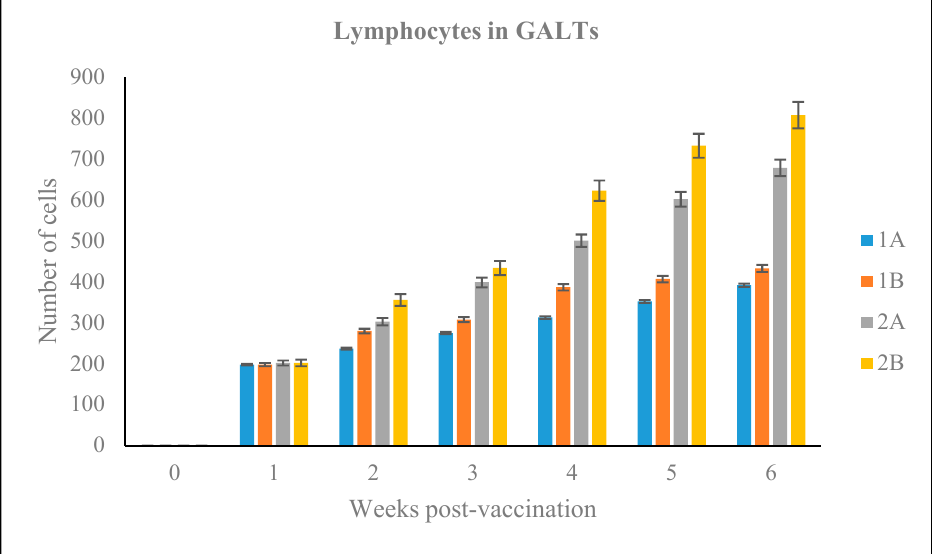
Figure 8. GALTs diameter observed in experimental groups after oral vaccination in the 6-week trial.